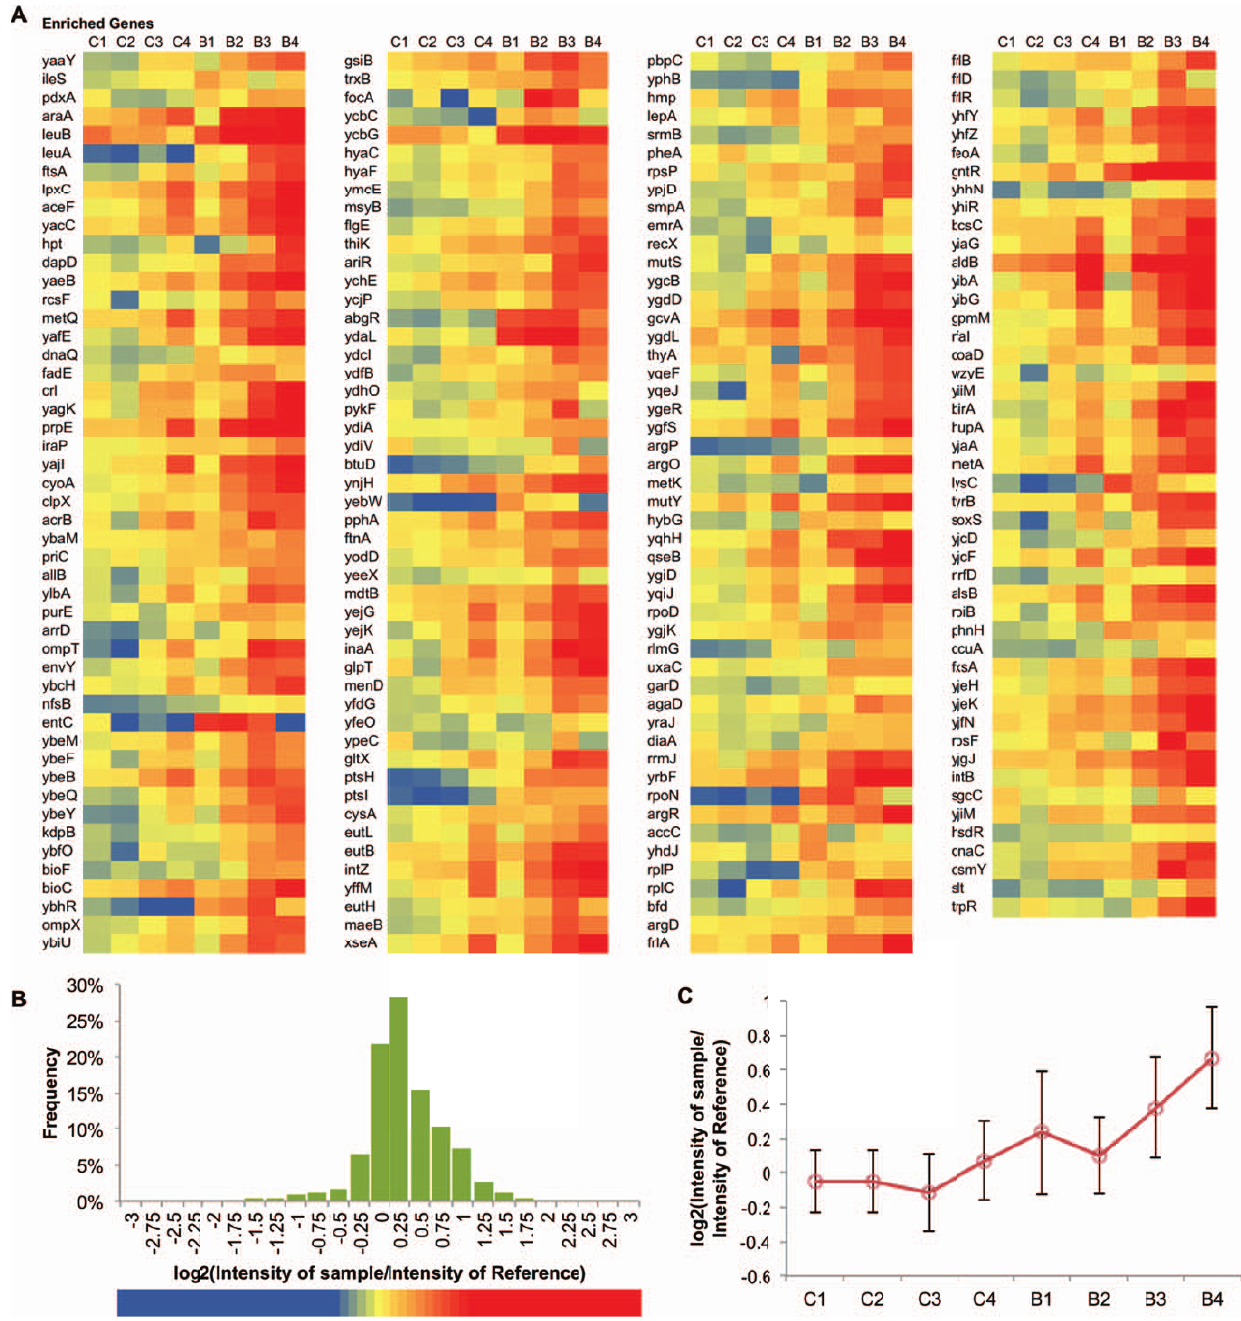
Figure 1. Profiles of genes significantly enriched in the n-butanol challenge. A . Heat map of all genes enriched. B. Histogram of the range of normalized log 2 (Intensity of sample/Intensity of reference) . The colored bar at the bottom part of the figure is the legend for Figure 3A. C. The averaged